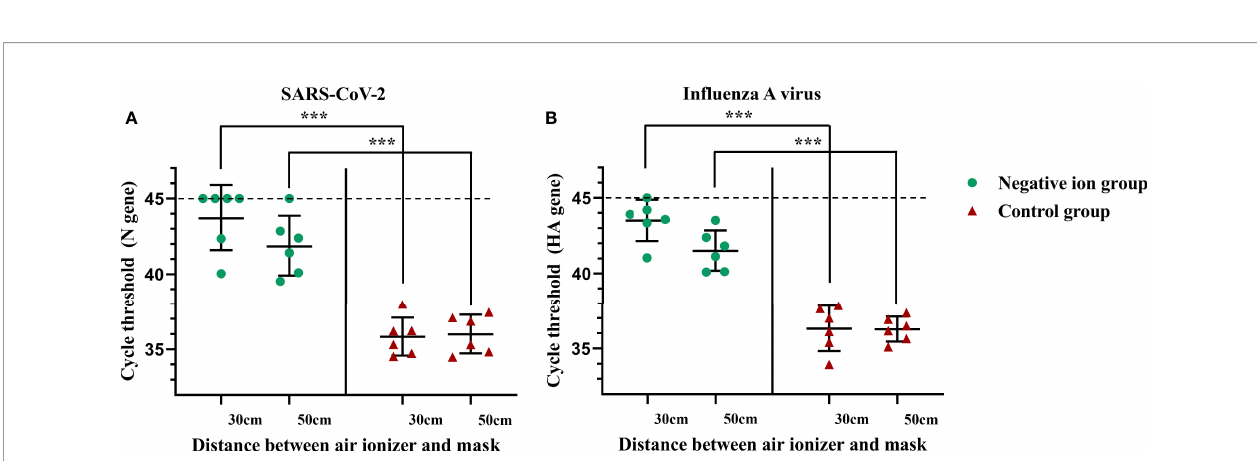
FIGURE 3 | Aerosolized virus disinfection effect by negative ions. A 24-jet Collison-type nebulizer was used to aerosolize the virus suspension. A button sampler was placed at the same height, 50 cm horizontally, and used to sample the air with a fl ow rate of 4 L/min. The air ionizer was placed 30 (A, C) or 50 cm (B, D) below the button sampler. When the 10-min sampling is over, the relative abundance of viral RNA in the air samples was compared when the ionizer was active or inactive. The bar means: Mean ± SD. *** means P value <0.001.